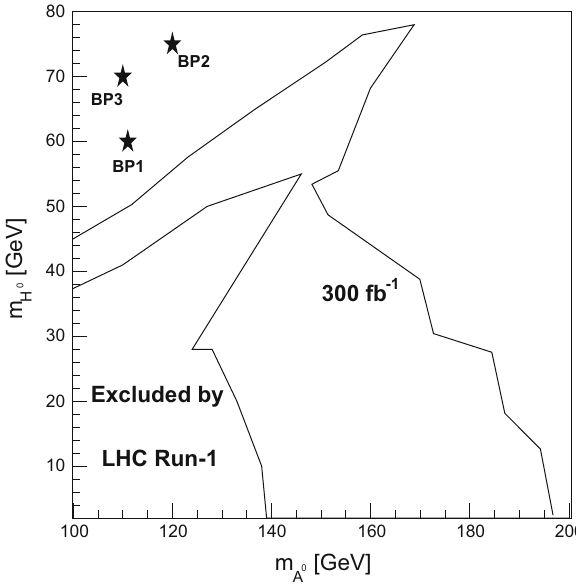
Fig. 1 The chosen benchmark points and the LHC exclusion area noted above, there are theoretical and experimental bounds constraining the parameters λ 2 and λ L . Considering the per- turbativity and the tree-level unitarity constraints λ 2 ≤ 4 . 2. There is also a lower bound on λ 2 from positivity (6), = [ 0 , 4 π ] . Note that the parameter λ λ 2 2 , quartic self cou- 3 pling of the inert scalars, does not affect the value of relic density because the annihilation to the SM is mostly medi- ated through the SM-like Higgs boson and the parameter λ L . Therefore λ 2 does not enter to this study and the effect of that will only appear at one loop level. Parameter λ L < − 0 . 5 is excluded from the bounds on positivity. We fix the parame-